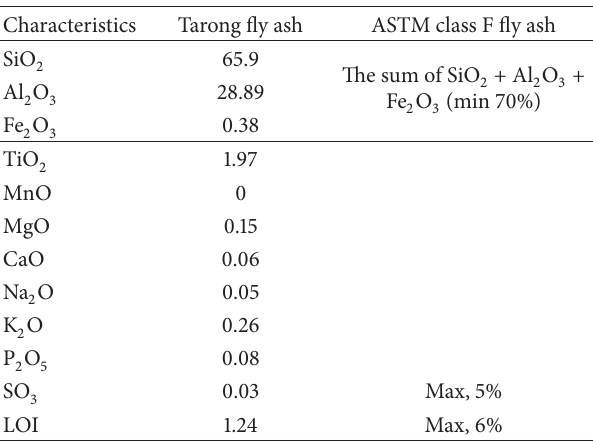
Table 2: Chemical composition of fly